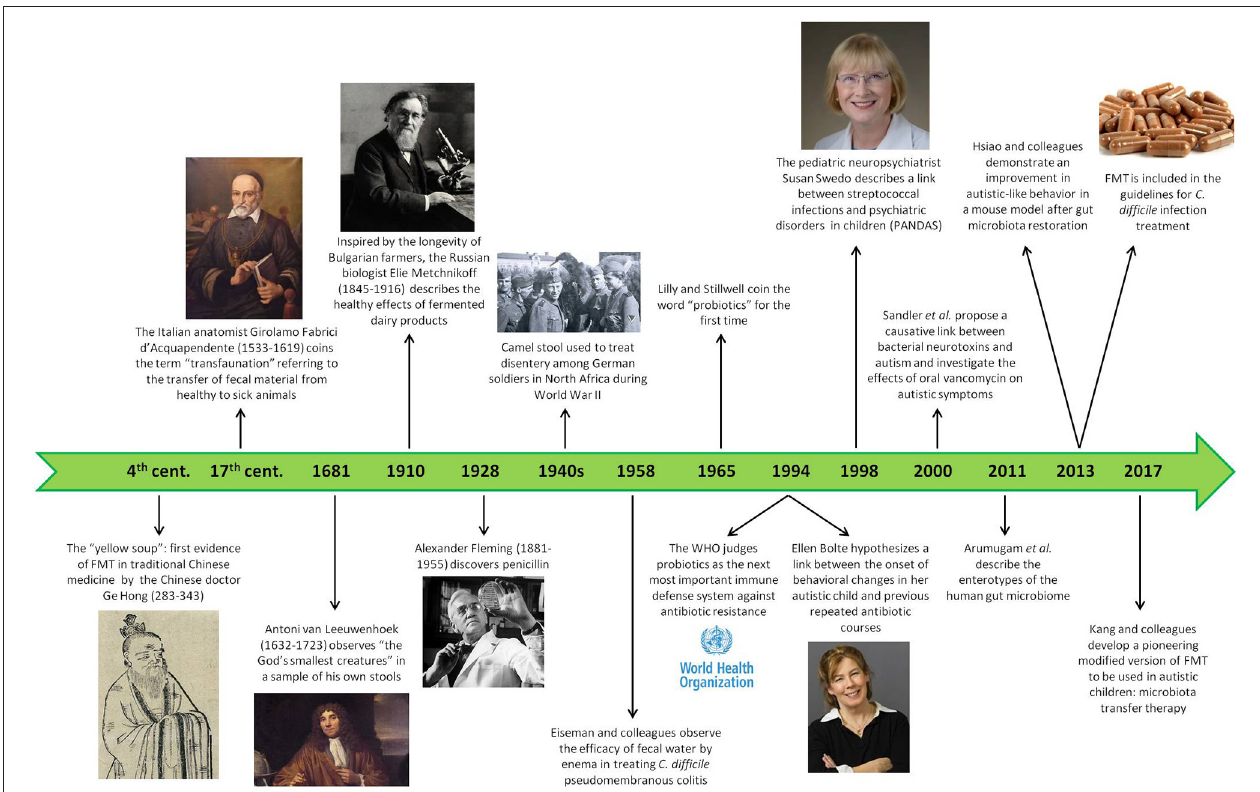
FIGURE 3 | History of the gut microbiota. This timeline shows the most significant facts about the attitude, the first trials, and the scientific goals in the field of intestinal microbiota during human history, starting from ancient times until